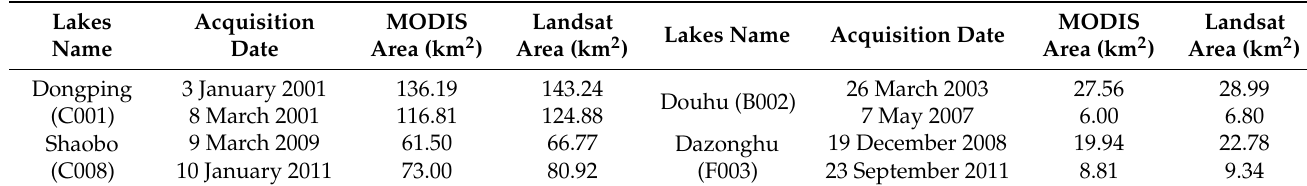
Table 2. Validation of the MODIS water extraction maps based on Landsat images.